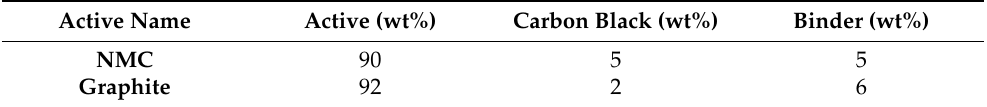
Table 1. Electrode